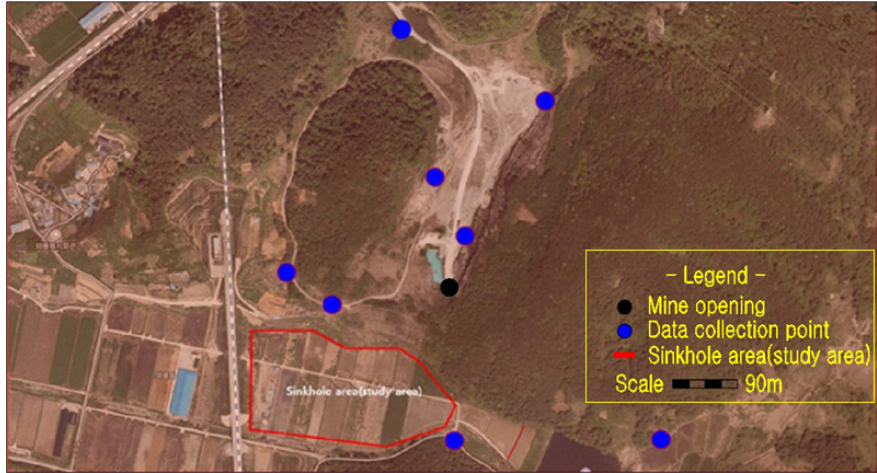
Figure 9. Location of discontinuities data collection points.